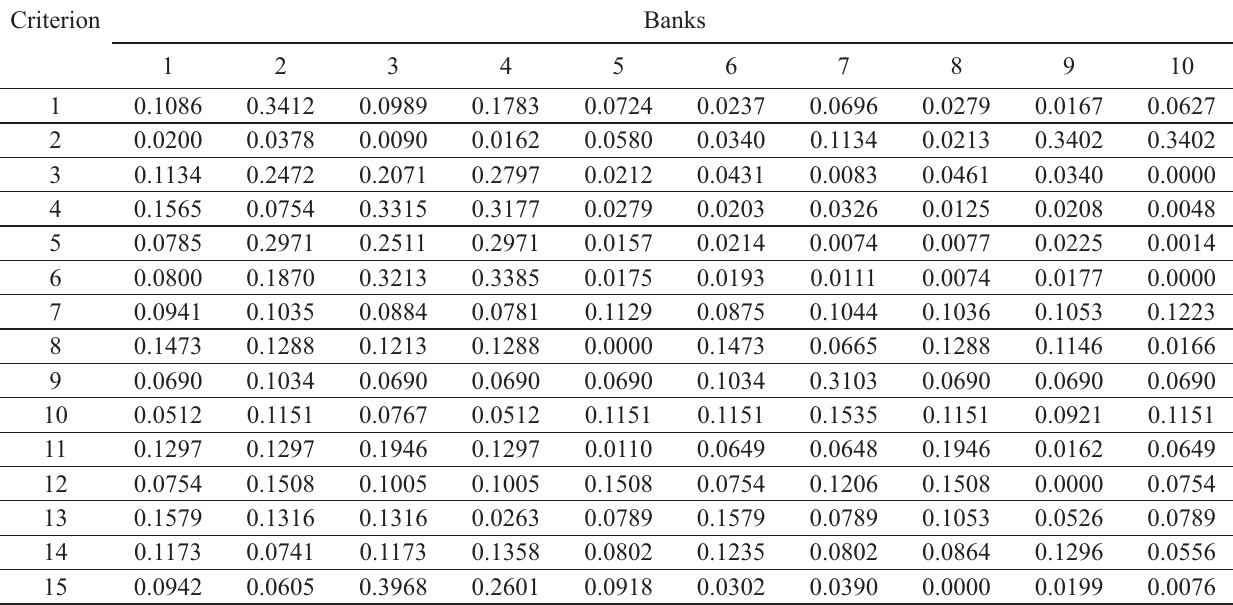
Table 5. The data on the commercial banks of Lithuania for 2007 normalized by the method SAW